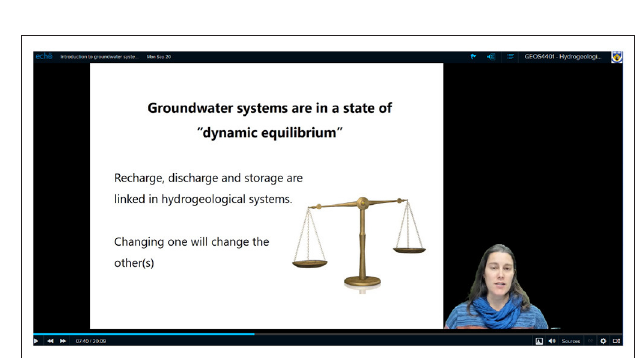
FIGURE 2 | Screen-shot of video recording captured in one of UWA’s purpose-built recording studios and deployed to students through the Lecture Capture system, featuring author